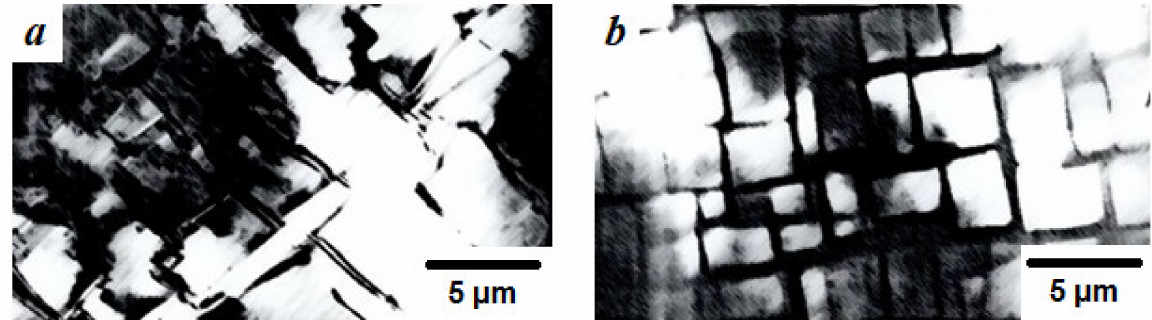
Figure 5. Morphology of precipitation of the main strengthening γ (cid:48) -phase in the structure of the alloy: ( a ) finely dispersed strengthening γ (cid:48) -phase in the axes of dendrites; ( b ) coarse hardening γ (cid:48) -phase in the interdendritic space.